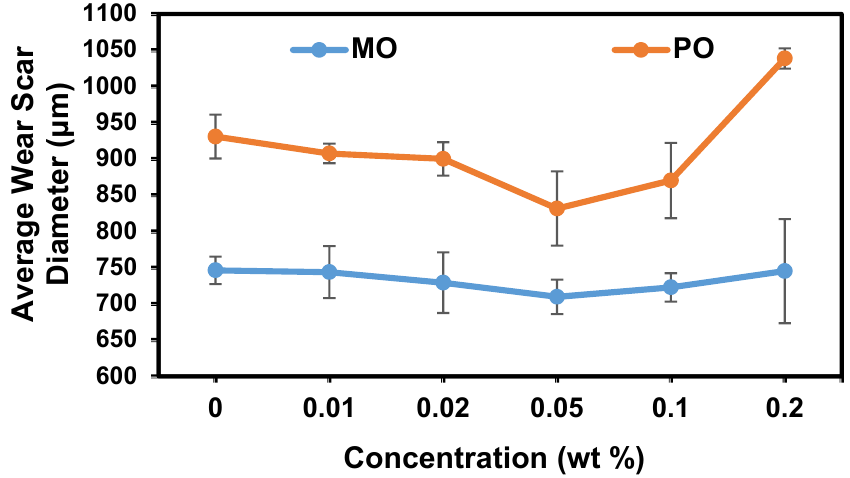
Figure 4. The COF results achieved using both PO and MO oils with different GNPs concentrations (0 to 0.2 wt %).